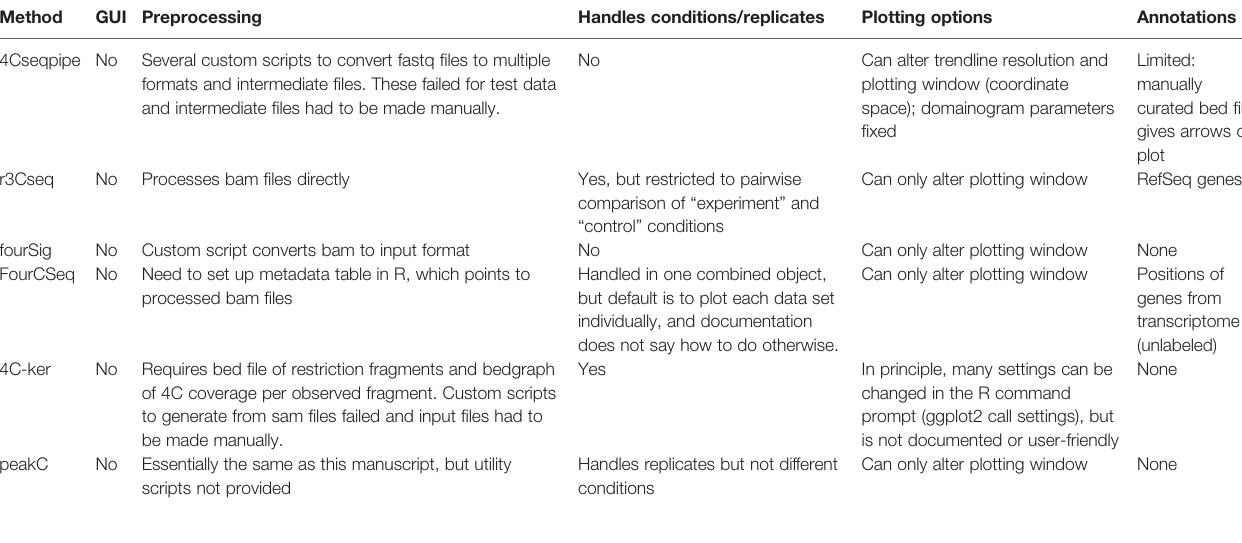
TABLE 1 | Comparison of graphing options from existing 4C analysis